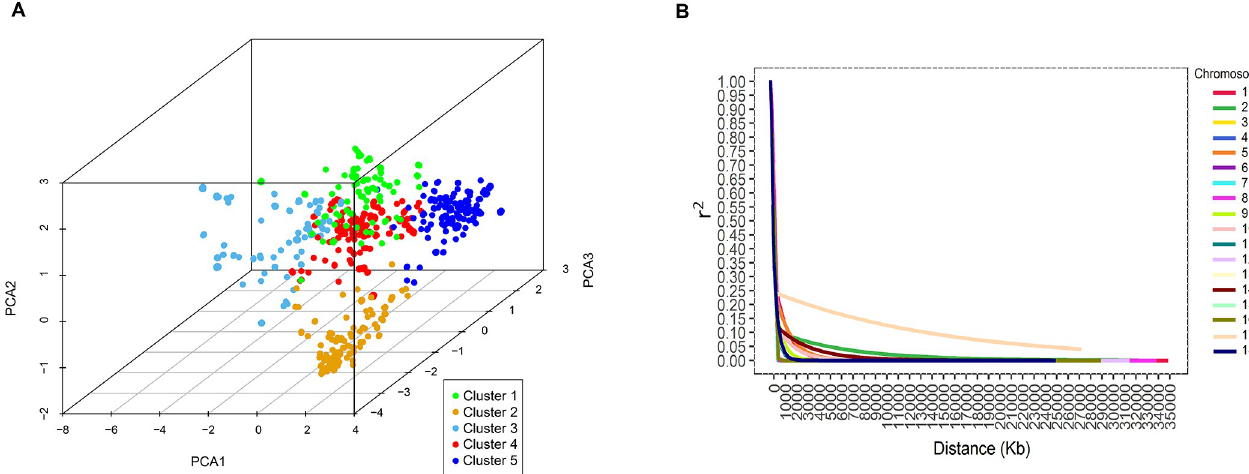
Fig 3. Principal component analysis (PCA) and genome-wide linkage disequilibrium decay. (A) 3D PCA of the kinship matrix obtained from 23,078 SNP markers of 876 cassava samples allocated in five clusters. (B) Genome-wide linkage disequilibrium decay of r2 values against physical distance (Mb). The lines in different colors indicate the adjustment of the loess regression to LD along the 18 cassava